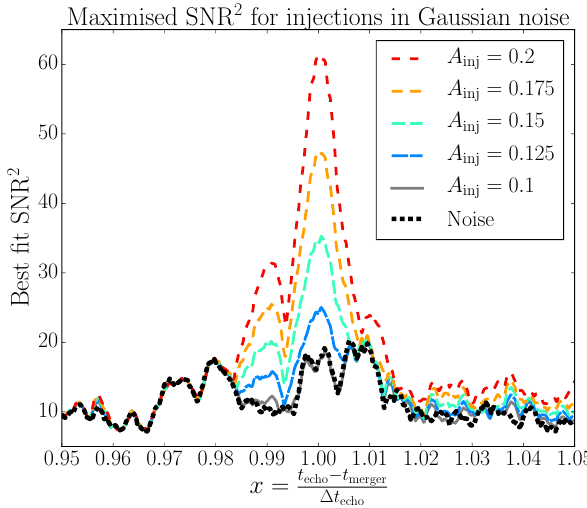
FIG. 2. The matched filtering technique is able to recover signals with a variety of amplitudes. As shown here, the SNR depends on the amplitude of the signal. The amplitude found by ADA ( A = 0 . 1) is close to the level that is found in pure Gaussian noise. An amplitude twice as large as this would be clearly identifiable in the data.